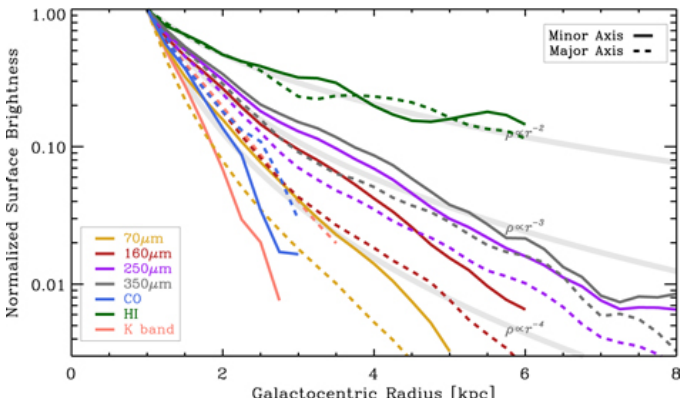
Figure 3. The radial profiles of gas tracers along the major and minor axes. The intensities are normalized to the one at r = 1; the x -axis shows a distance from the center of M82 along the radial (major axis) or vertical (minor axis) directions. Shown are: dust emission at 70, 160, 250, and 350 µ m, 12 CO( J = 2 − 1) 1.3 mm, HI and stellar emission in K -band 2.159 µ m, as indicated in legends. Credit: Leroy et al. [93]. Profiles along the minor and major axis are depicted by solid and dotted lines. Radial profiles r − 2 , r − 3 and r − 4 shown in gray illustrate diverging and converging constituents when integrated from [93], their Figure 13. Reproduced with permission from A. K. Leroy et al., published by AAS (ApJ)